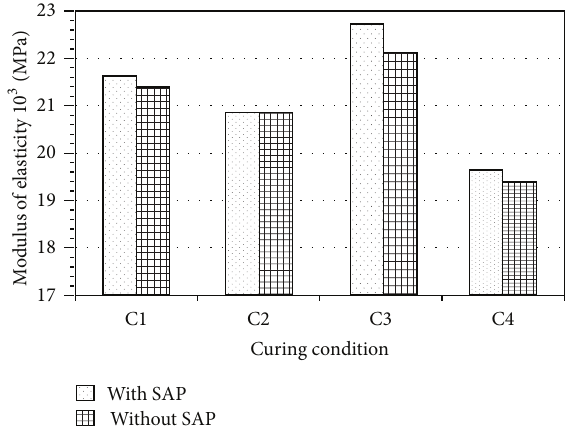
Figure 7: Test results on modulus of elasticity of different type of